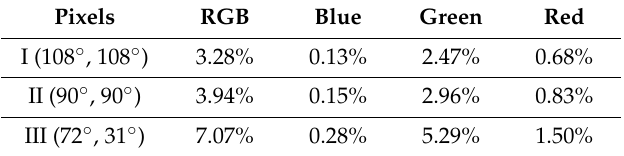
Figure 7. Ambient light reflection for red, green, and blue (RGB) subpixels of structure III. Table 3. Luminous ambient reflection for RGB subpixels of structure I, II, and III.